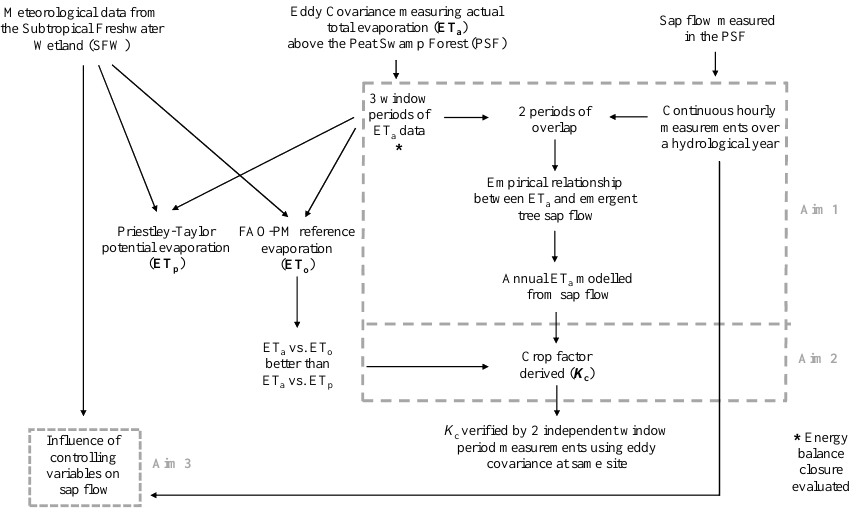
Figure 1. Flow diagram of the research strategy indicating the different measurement techniques, their combination, and link to the aims of the